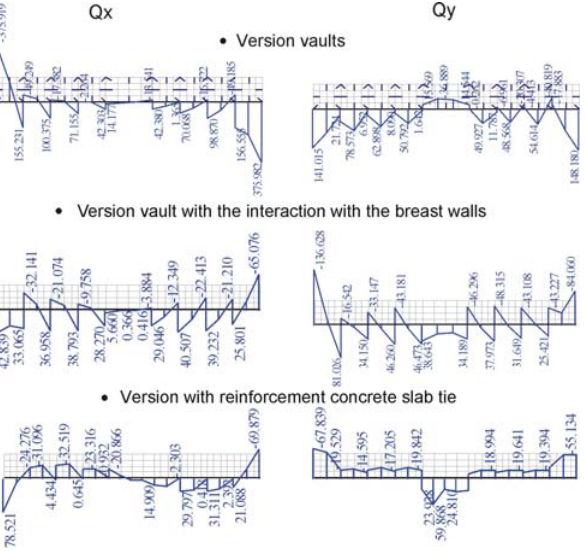
Fig 14. Course of shifting forces Q x , Q y at vault toe ad- joining bridge pier in which shift in footing bottom oc-